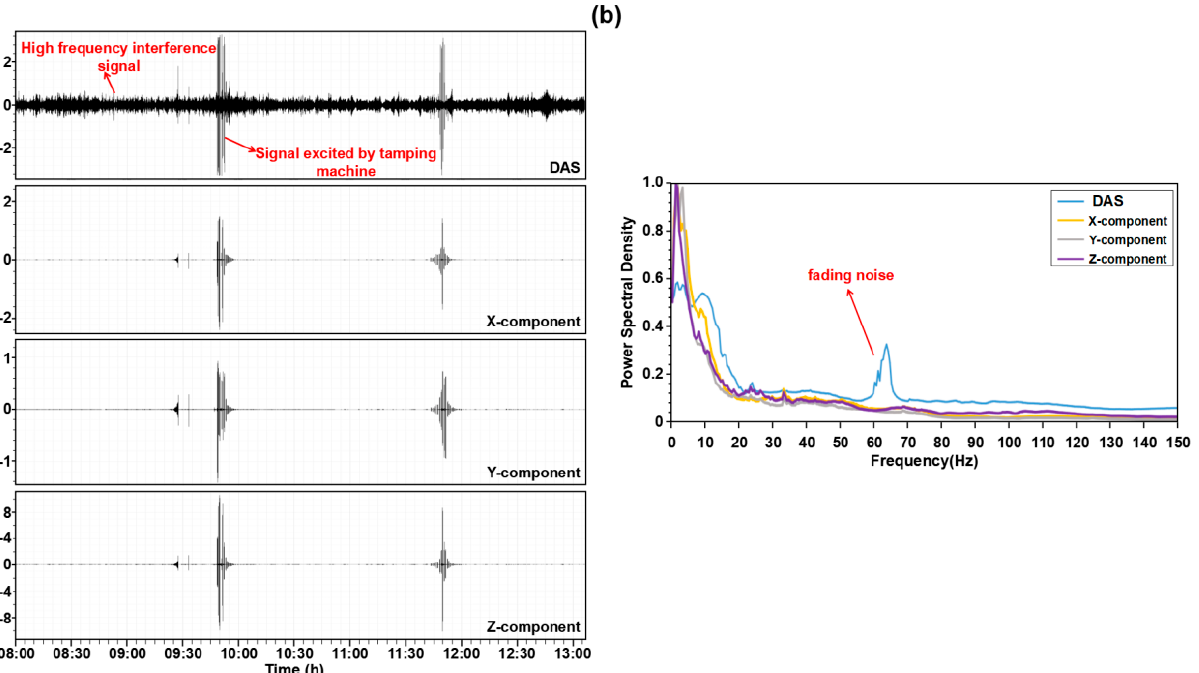
Figure 3. Raw data recorded by DAS and nodal seismometer. ( a ) Piece (5 h) of raw DAS and three- component nodal seismometer microtremor data. ( b ) displays average noise spectra computed over a large number of 2 s long time windows of microtremor data.